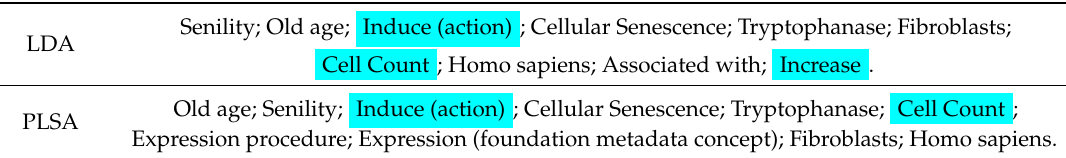
Table 11. The top-1 topic on the enabling replicative immortality (ERI) hallmark.